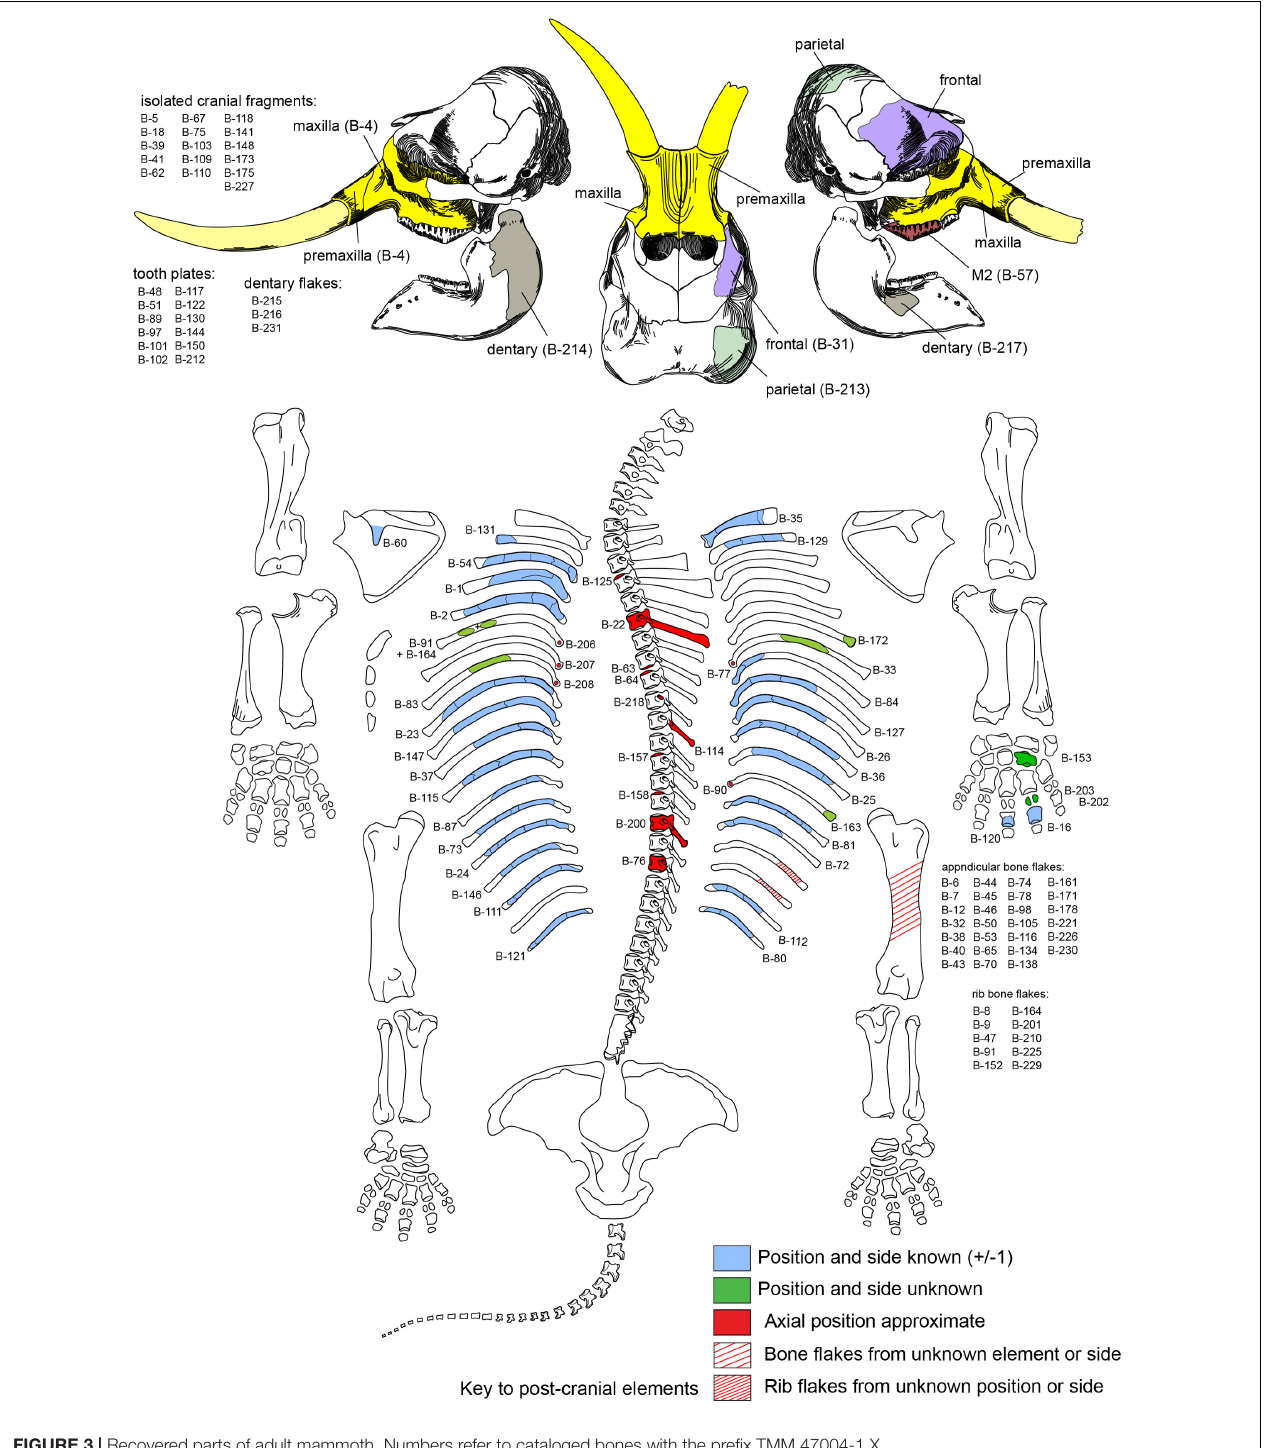
FIGURE 3 | Recovered parts of adult mammoth. Numbers refer to cataloged bones with the prefix TMM 47004-1.X.